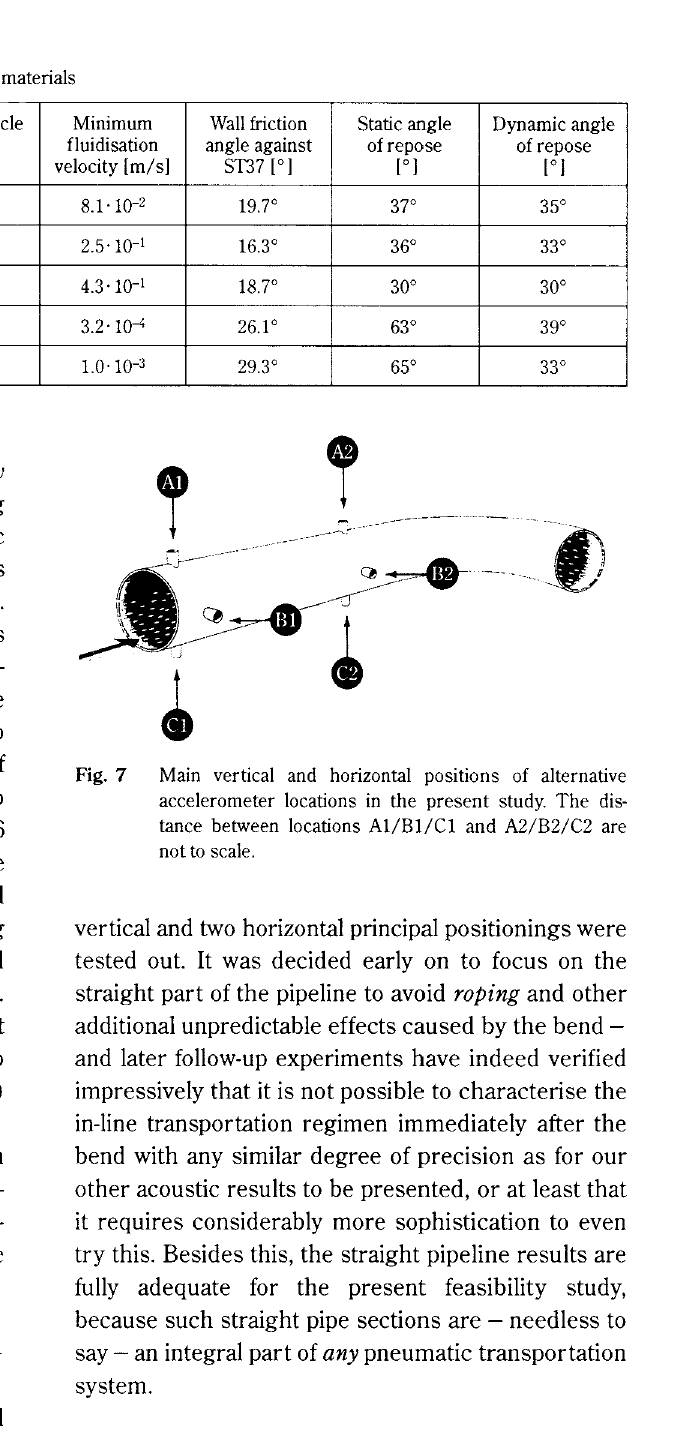
Table 1 Physical and pneumatic conveying characteristics of test materials